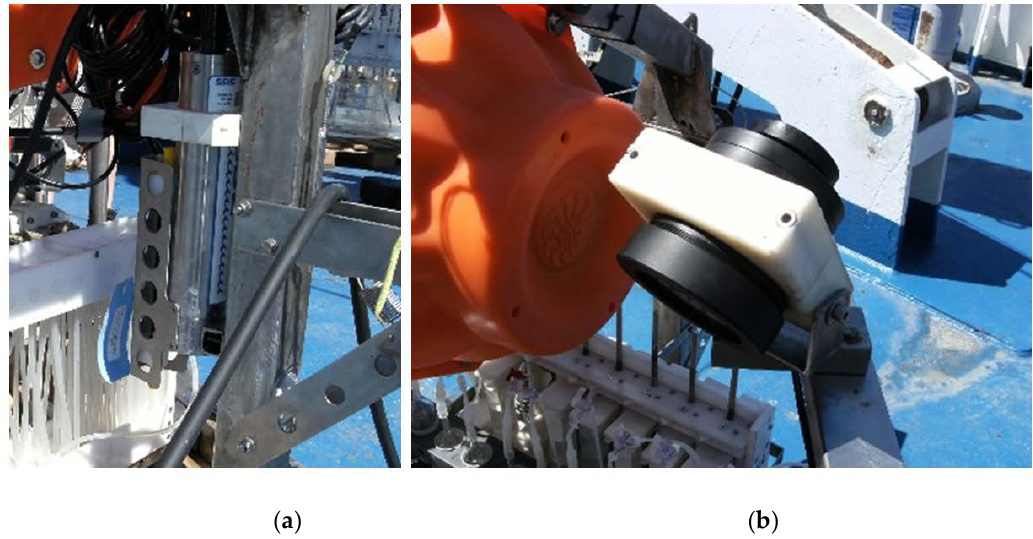
Figure A1. The Amerigo Lander monitoring instrumentation. ( a ) The SBE CTD mounted on the Amerigo tripod; ( b ) the Telesub Lanterna camera installed on the Amerigo Lander.